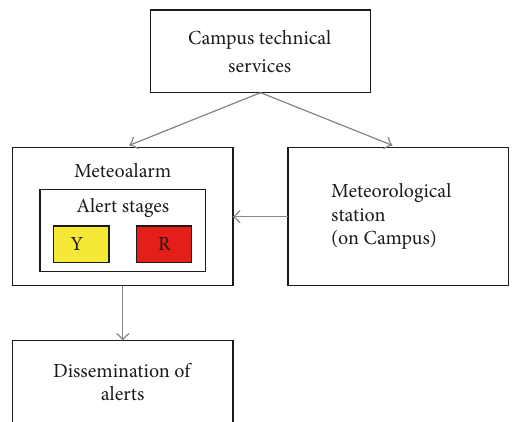
Figure 4: Scheme of the “procedure plan in a case of the emergency caused by stormy wind or hurricane, snow and occurrence of the ice on the University of Rijeka